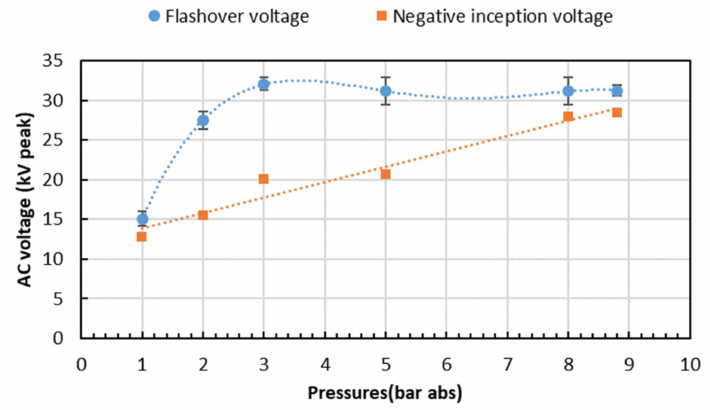
Figure 10. V mean Flashover and Negative inception voltages as function of gas pressure (CO 2 , PE-UHMW, Needle on HV electrode).